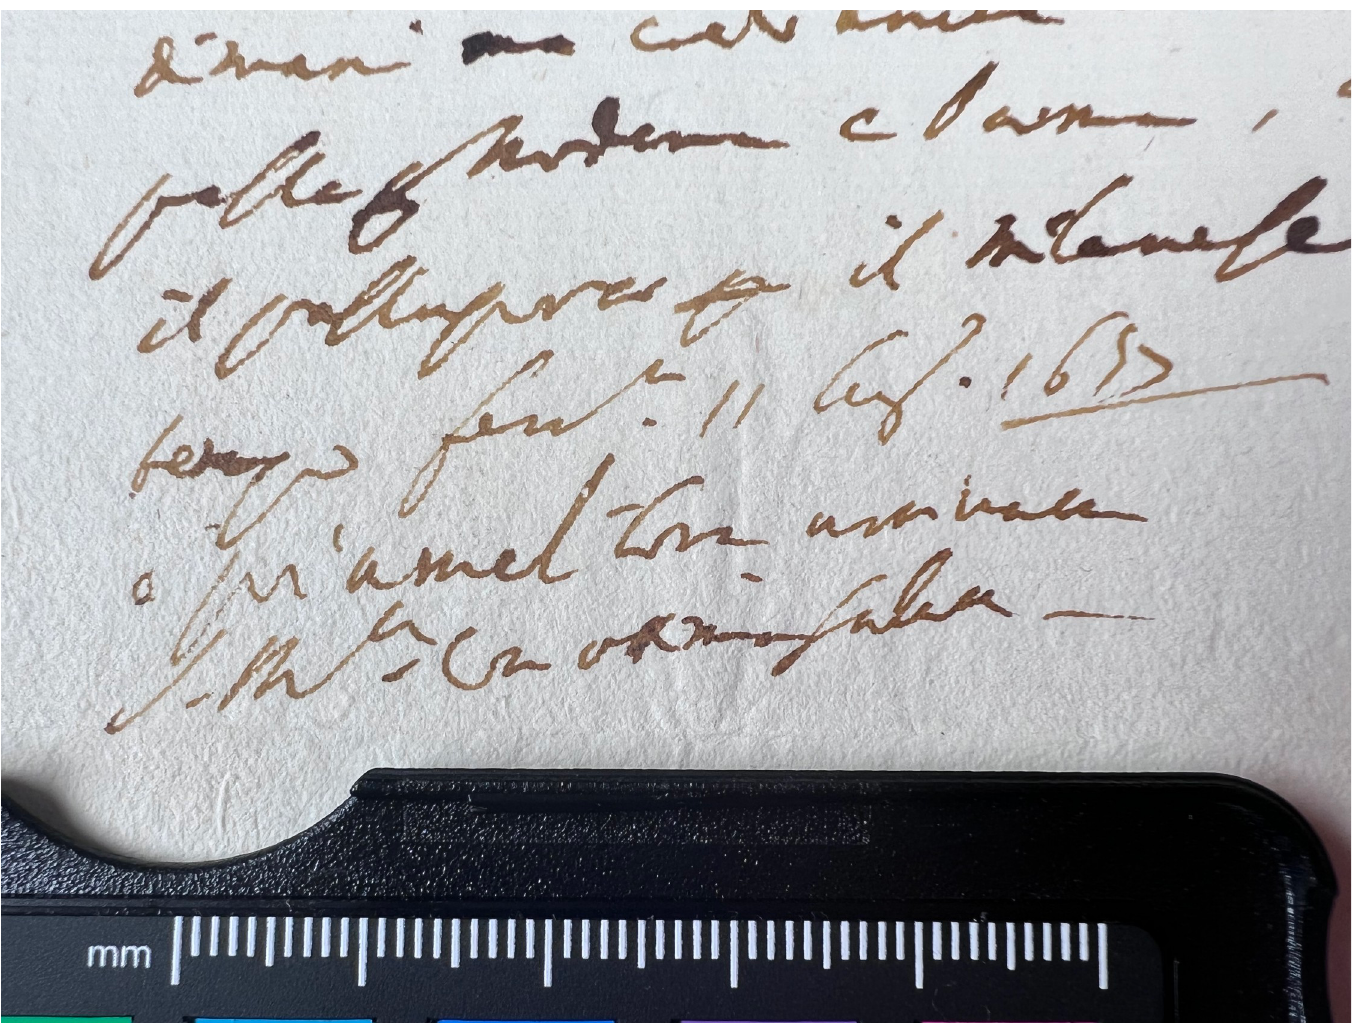
Fig 12. Ink thickness 1. Visual estimation of ink thickness 1, exemplified through a document from volume K 400 of the Azzolino collection.